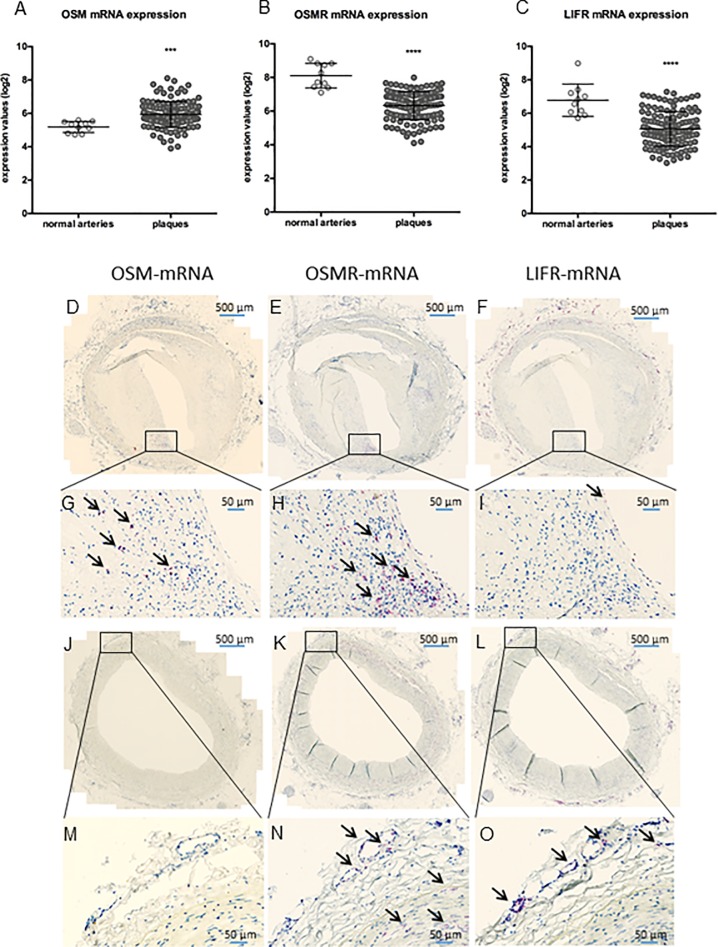
OSM, OSMR and LIFR mRNA expression is present in human atherosclerotic plaques.mRNA expression was measured in normal arteries and in carotid plaques by microarray analysis (A-C) and ISH was used to visualize OSM, OSMR and LIFR mRNA expression (red spots and shown by the black arrows) in two different stages of atherosclerosis development, the late fibroatheroma (D-I) and intimal xanthoma (J-O). A two-sided Student’s t-test assuming non-equal deviation was used to test for significance between normal and atherosclerotic arteries. ***p<0.001, ****p<0.0001.